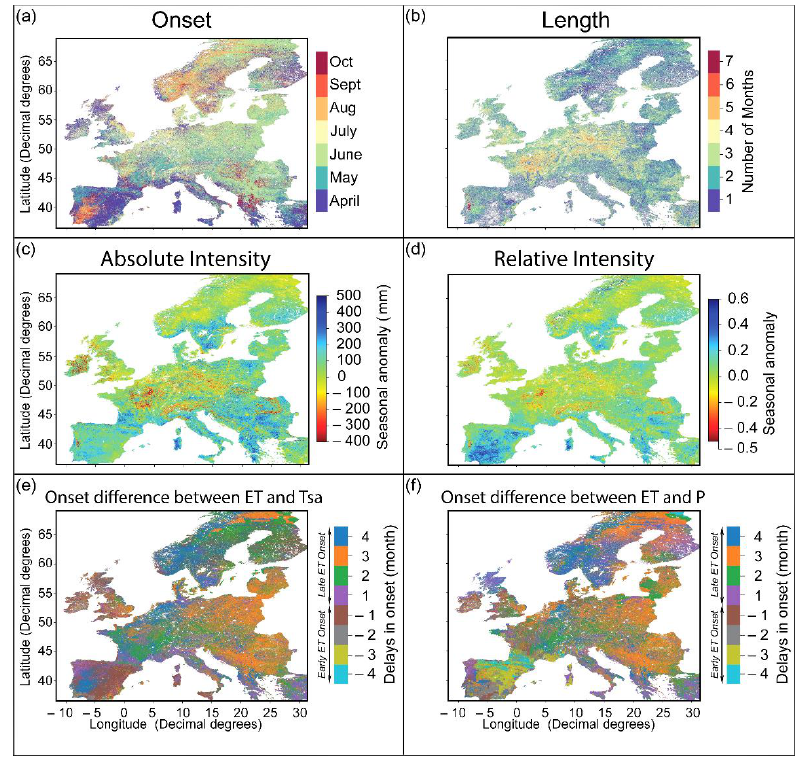
Figure 4. Characteristics of ecosystem response, represented as evapotranspiration (ET), to the extreme event. ( a ) Onset, ( b ) length, ( c ) absolute intensity, and ( d ) relative intensity of ET anomalies in 2018, and ( e ) difference between the onset of ET and surface air temperature (T sa ), and ( f ) difference between the onset of ET and precipitation (P).